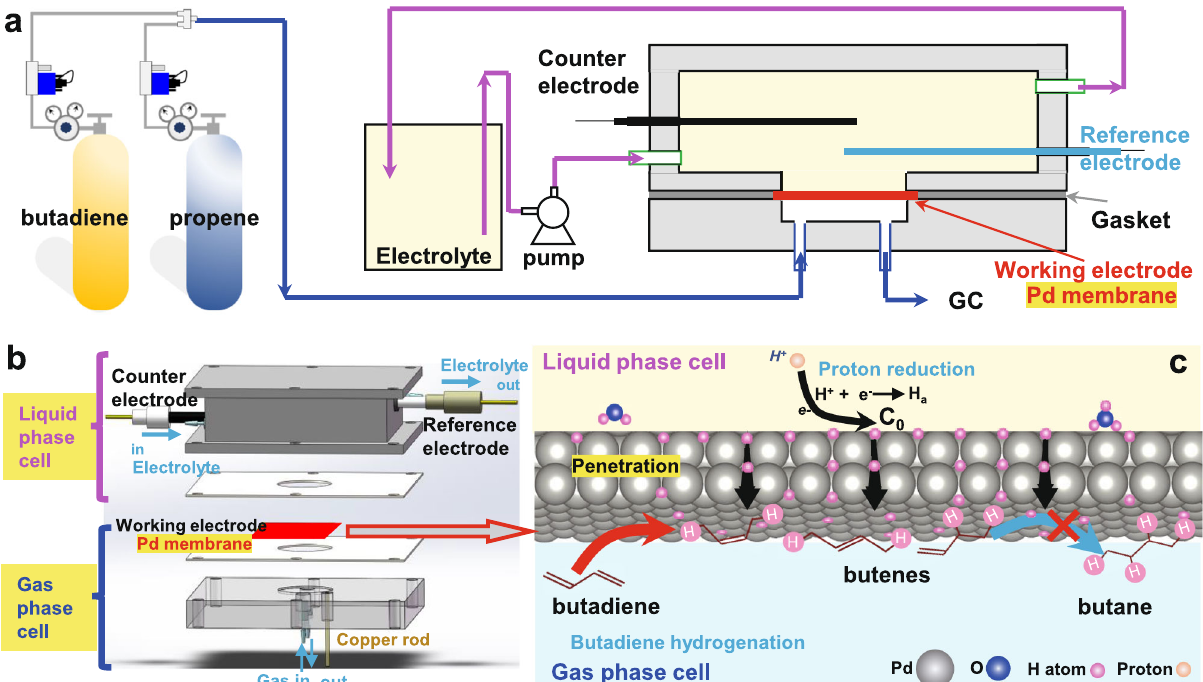
Fig.1|Electrochemistry-assistedselectivehydrogenationscheme.a Schemeoftheelectrochemical-assistedselectivebutadienehydrogenationsystem. b Construction of the gas feed fi xed bed reactor. c The proposed reaction